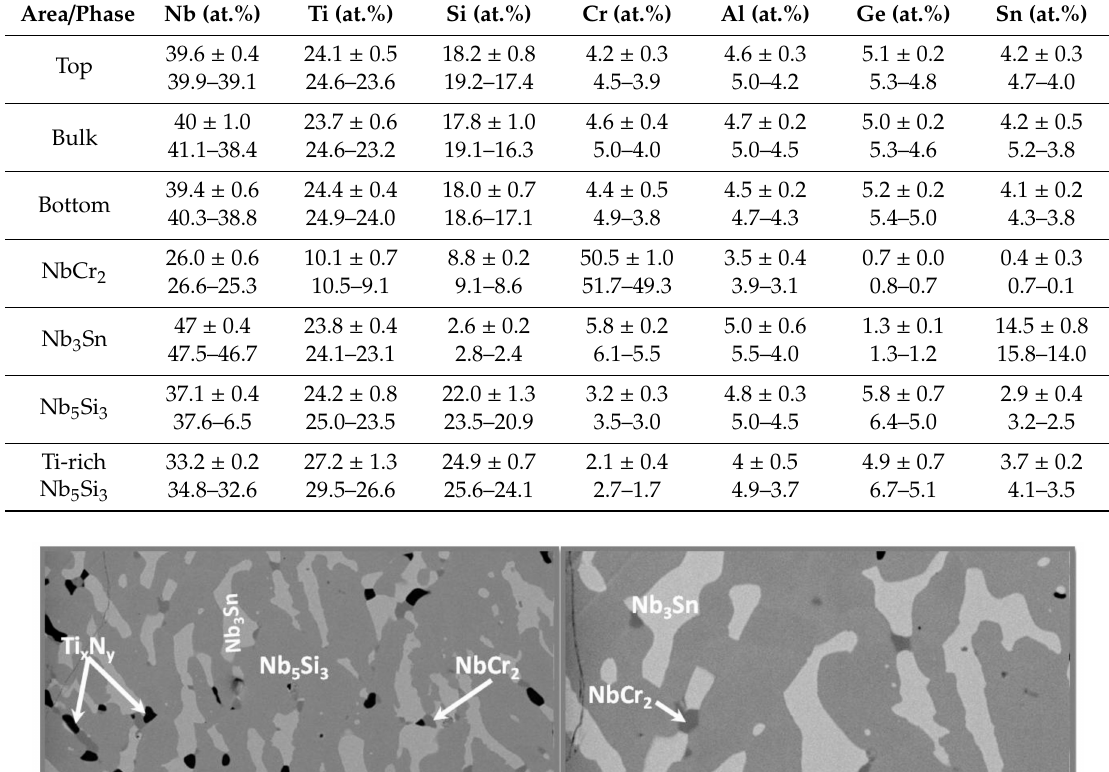
Table 2. Microanalysis data (at.%) of OHS1-HT.